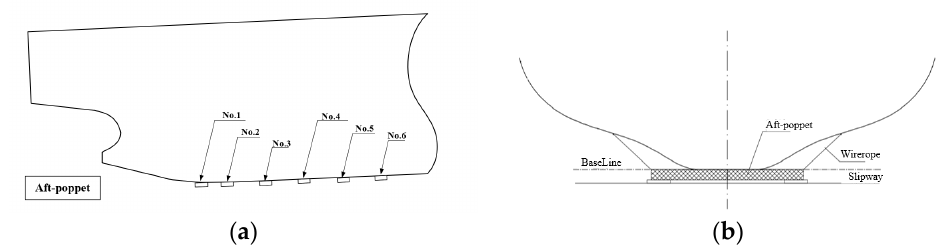
Figure 5. Schematic diagram of ship aft poppet: ( a ) longitudinal profile view and ( b ) back elevation view.